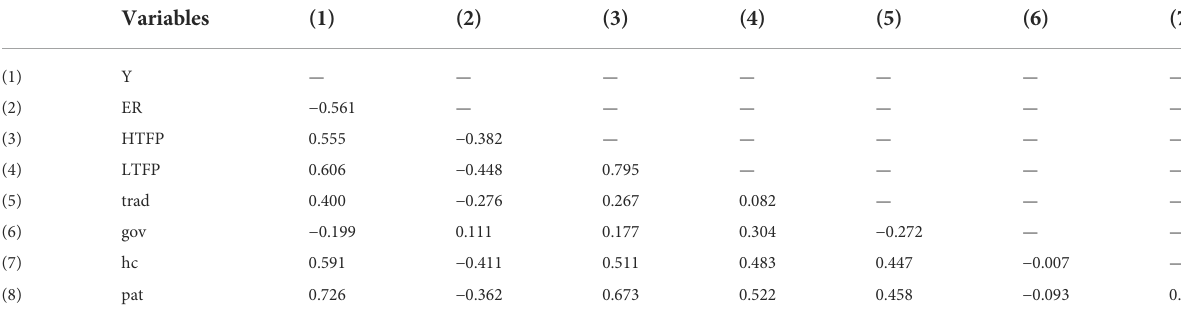
TABLE 3 Correlation coef fi cient of